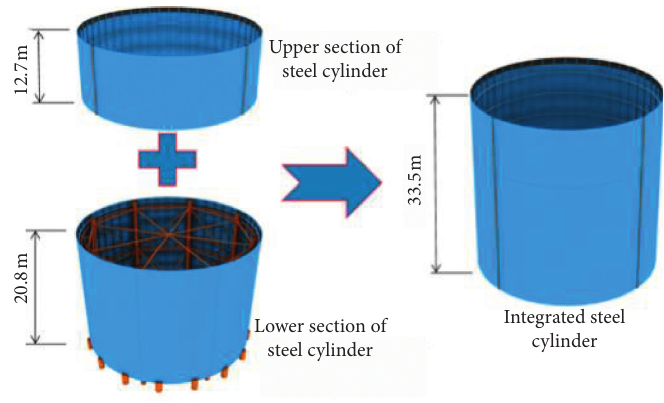
Figure 8: Horizontal